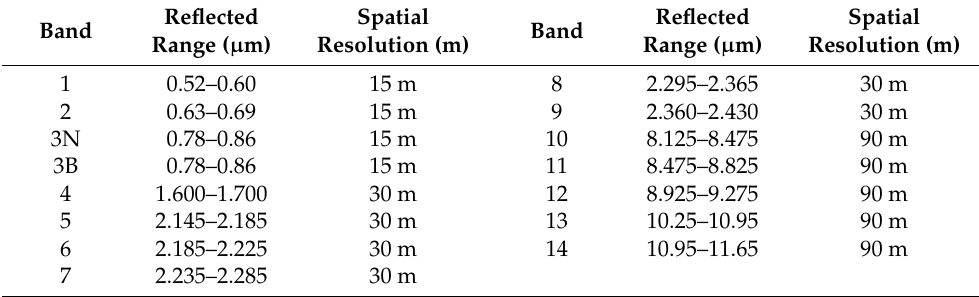
Table 1. Aster spectral